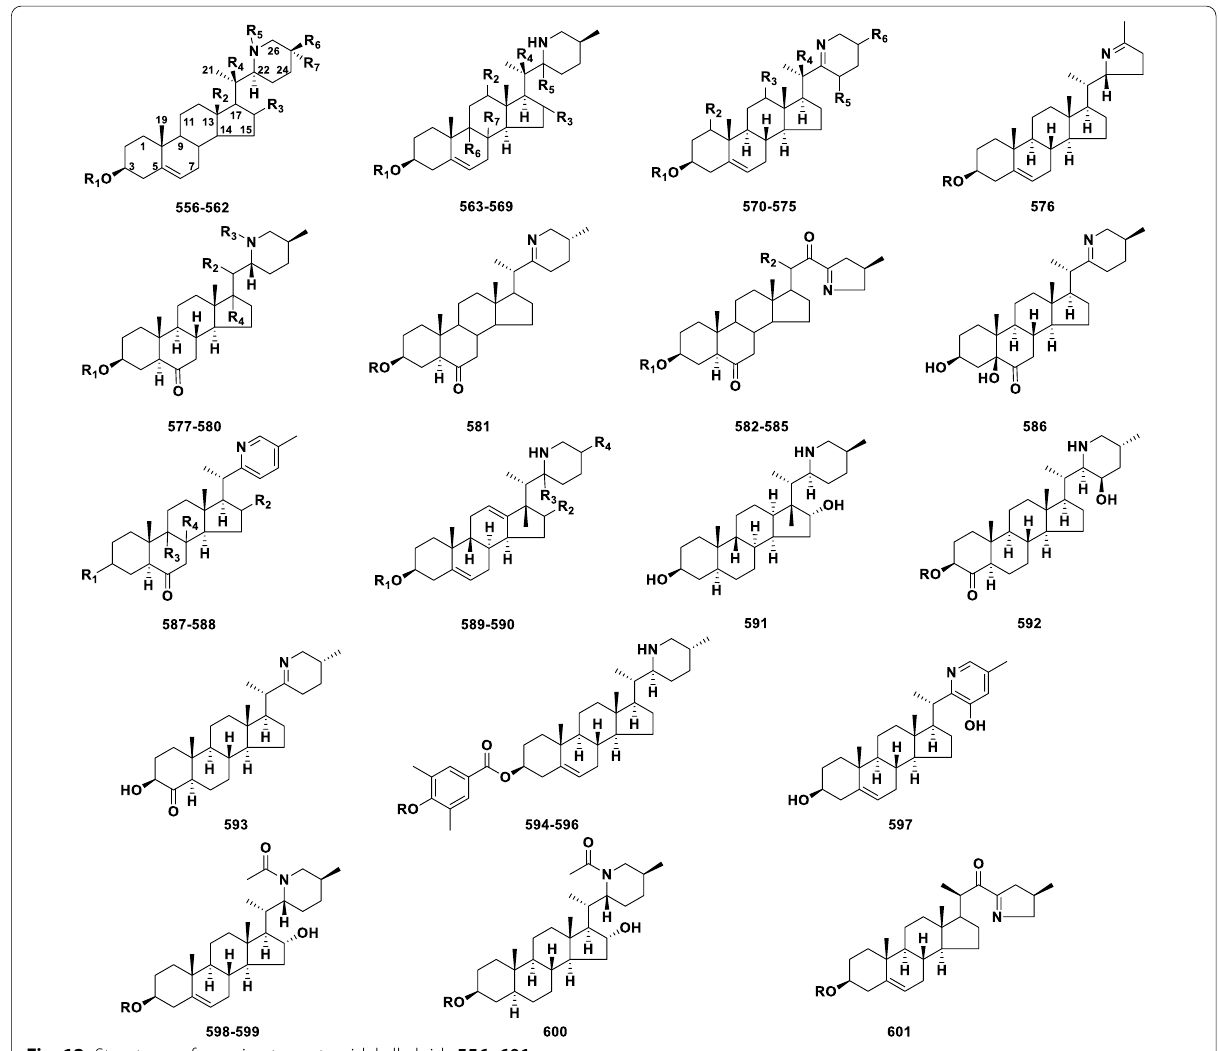
Fig. 12 Structures of verazine type steroidal alkaloids